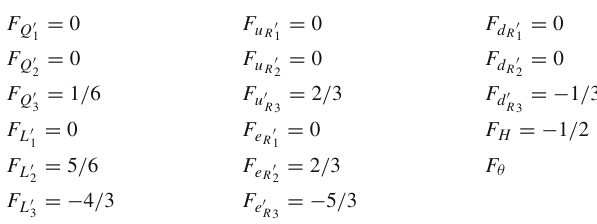
Table 2 U ( 1 ) F charges of the fields in the Deformed Third Fam- ily Hypercharge Model (DTFHM). All gauge anomalies, mixed gauge anomalies and mixed gauge-gravity anomalies cancel with this charge assignment, which has been previously listed in an ‘Anomaly-Free Atlas’ in Refs. [21,60]. At this stage, F θ is left